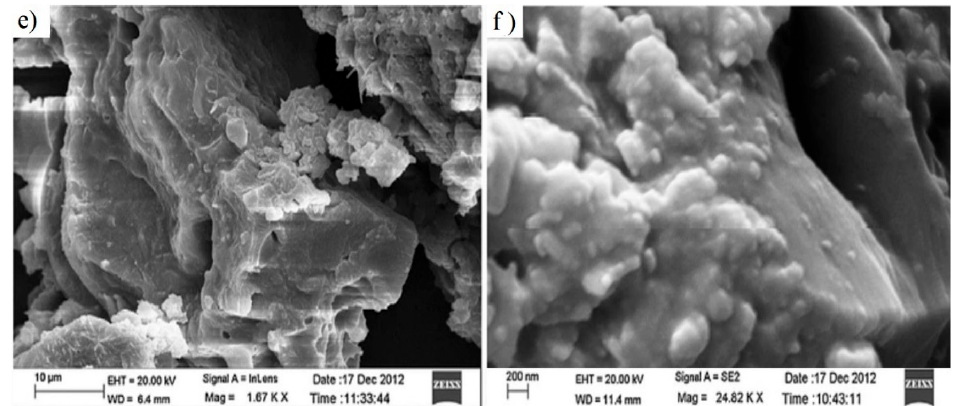
Figure 5. SEM images of sand samples with ( a ) 0.45 wt.% and ( b ) 0.90 wt.% clay NPs after polymer